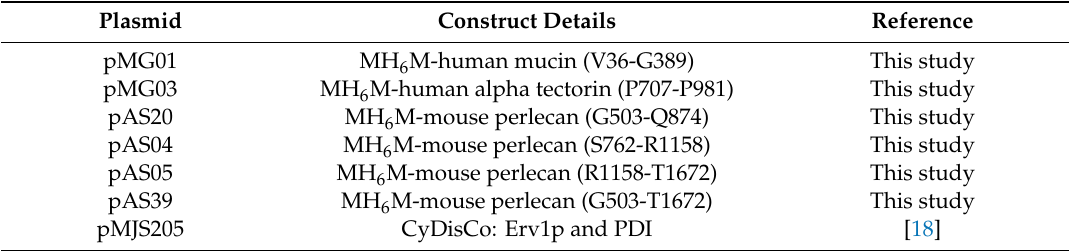
Table 3. Plasmids used in this